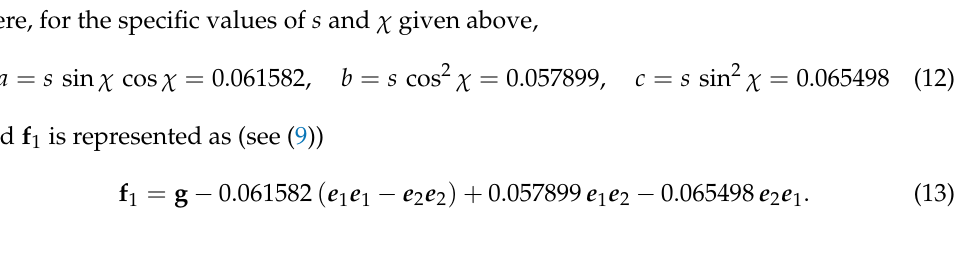
2 3 (cid:48) by shifting its part − − 2 3 by − − 2 (on the right −